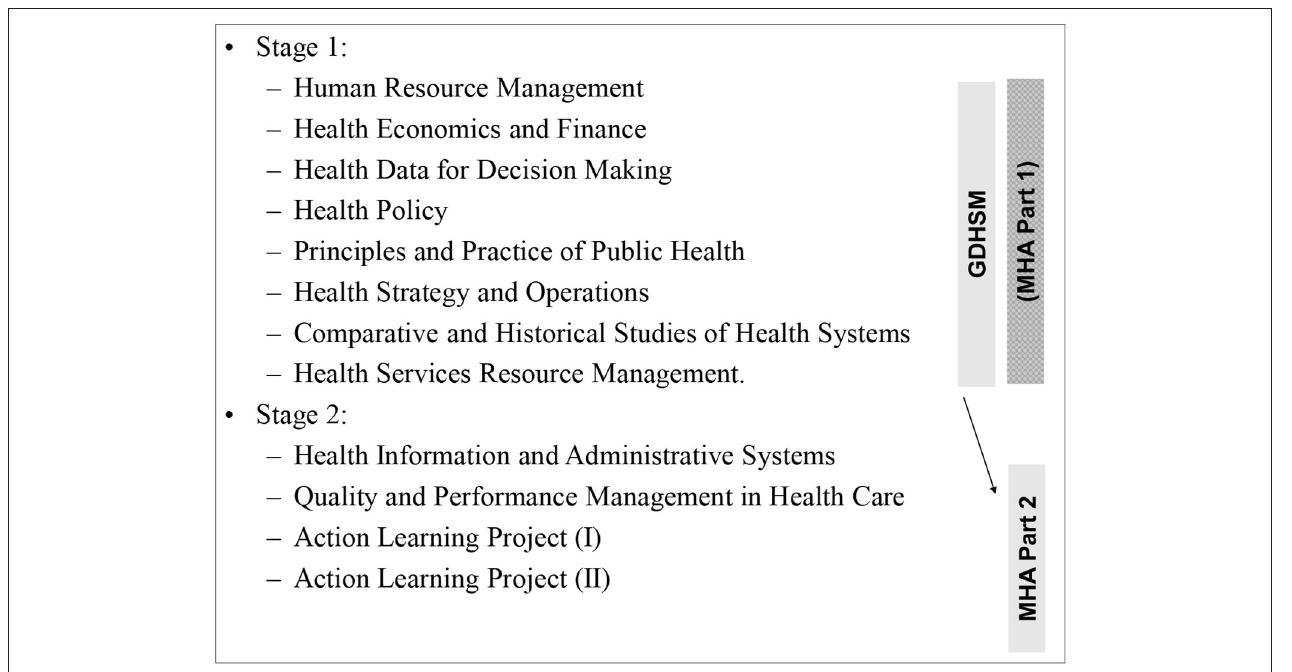
FIGURE 1 | Standard sequence of study and course enrolments offered as part of the